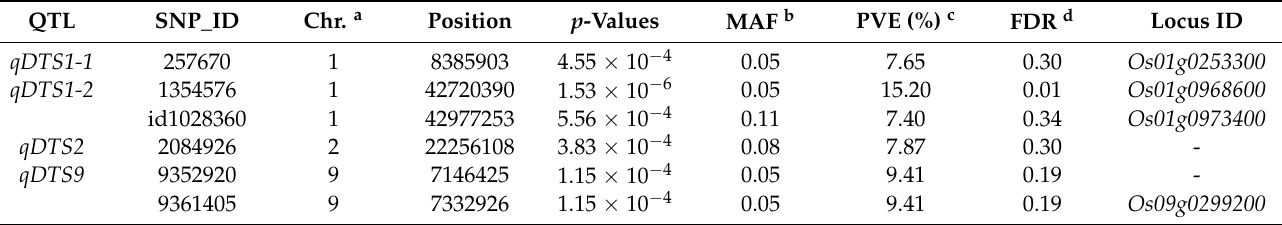
Figure 3. GWAS for salt tolerance at the seedling stage in the japonica -MAGIC population. Manhattan plot ( a ) and quantile-quantile plot ( b ) for the GWAS in the japonica -MAGIC population using the MLM. The horizontal line indicates the threshold value ( p = 5.0 × 10 − 4 ). Table 2. Significant SNPs for salt tolerance at the seedling stage from GWAS